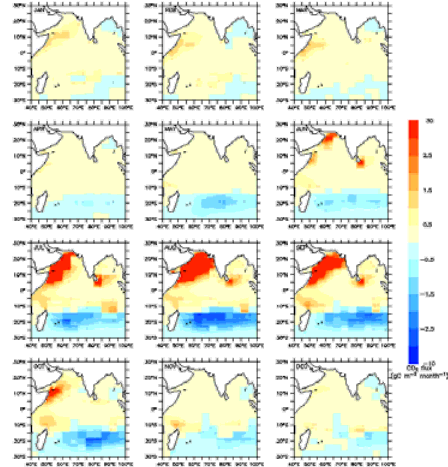
Figure 1 Monthly maps of air-sea fluxes of CO 2 over TIO during a climatological year 2002-2009. With the arrival of southwest monsoon over India and surrounding region in June, CO 2 levels declined over north TIO and over the terrestrial India. There is a local and isolated minimum of CO 2 observed over central India. Through the progress of southwest monsoon in July and August, atmospheric CO 2 levels further declines over most part of Indian Ocean.